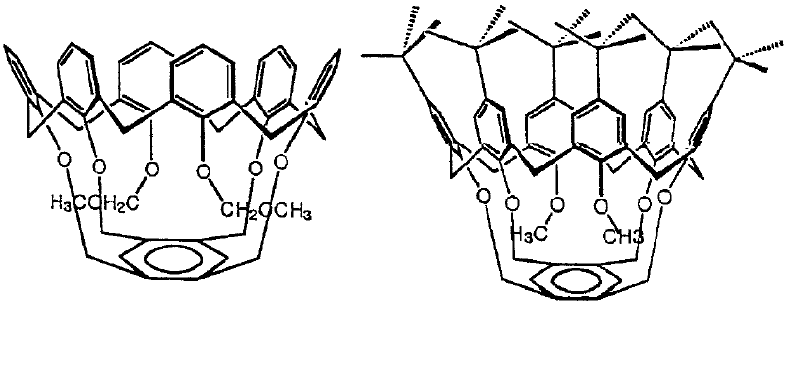
Figure 17. Quadruply-bridged